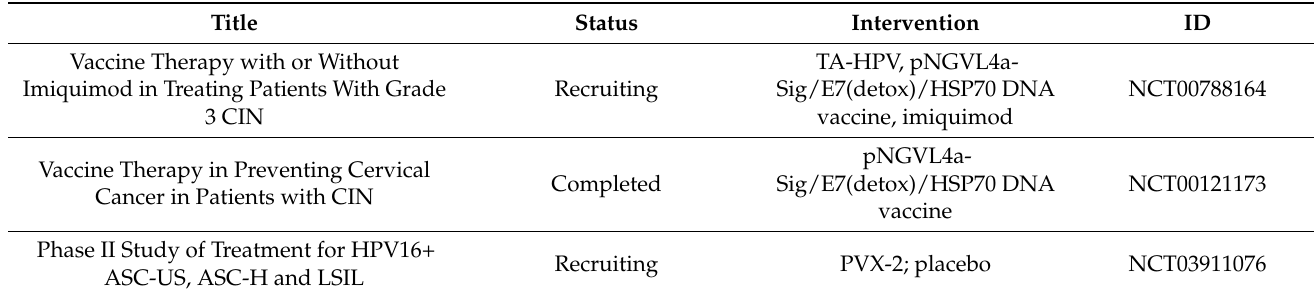
Table 4. Hsp70 vaccination cervical cancer prevention